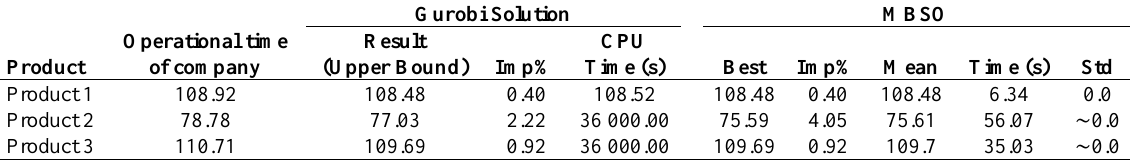
Table 6. Gurobi and MBSO results for three